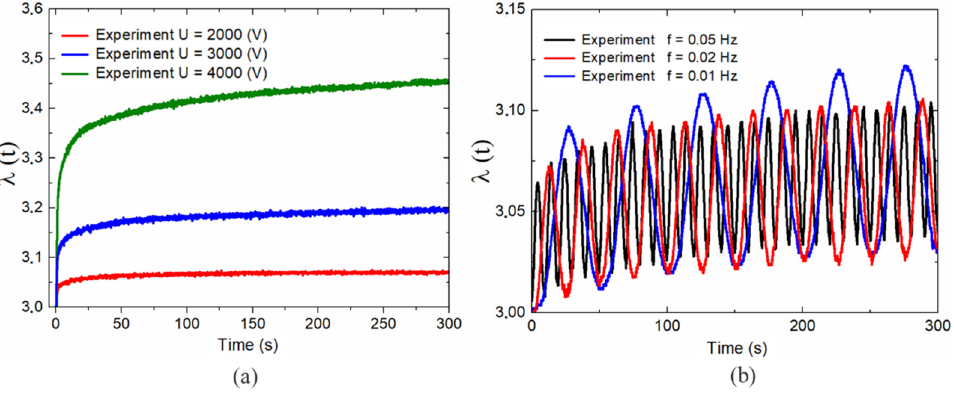
Figure 4. Experimental results: ( a ) step response and ( b ) alternating response with U = 2000sin2 π ft ( V )